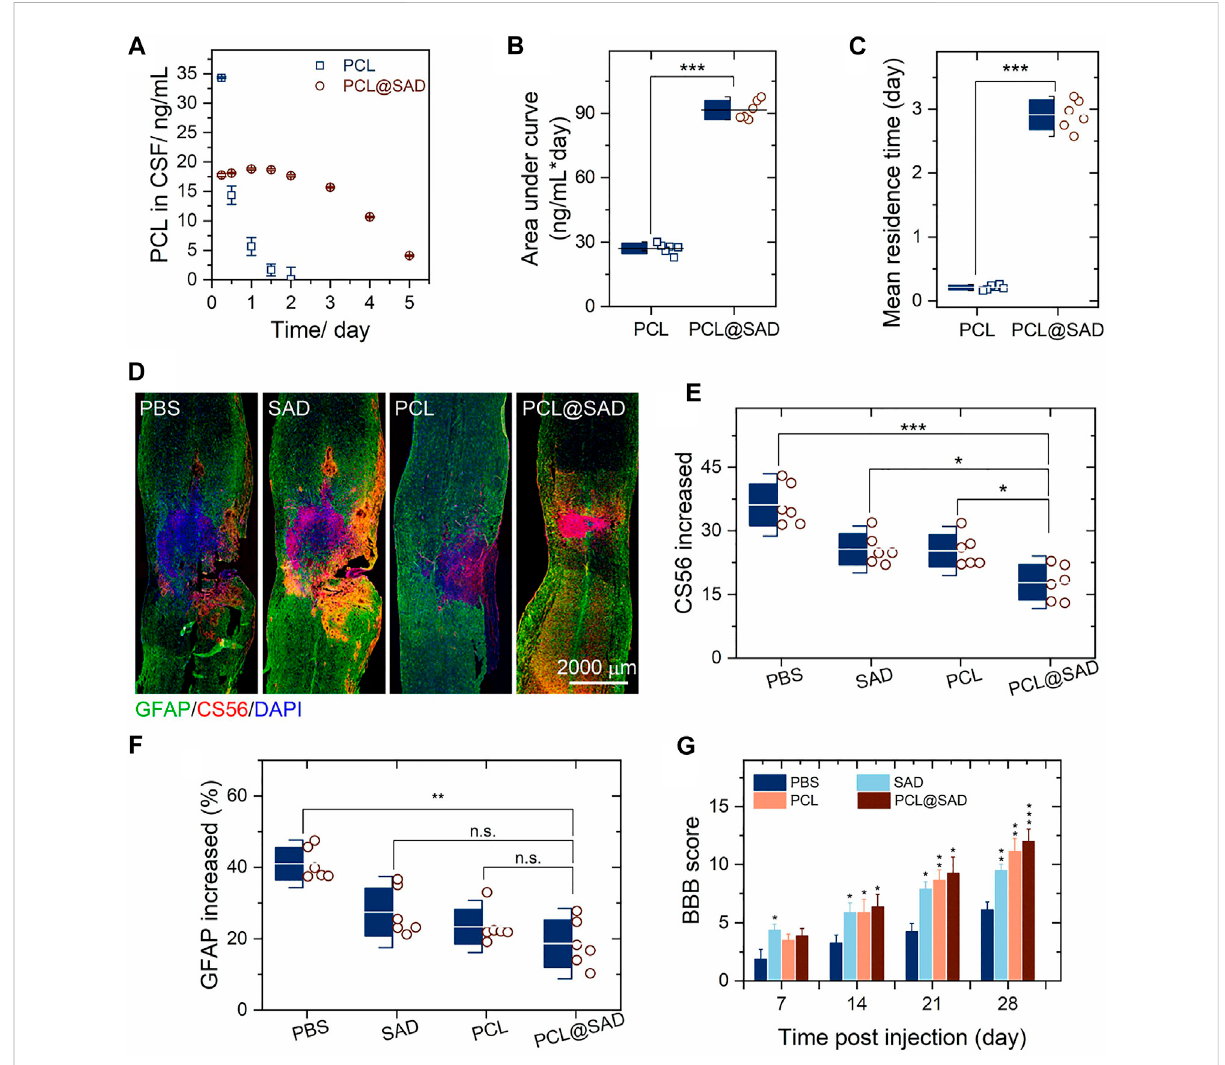
FIGURE 3 PCL@SADimprovesfunctionalrecoveryafterspinalcordinjury( n =6). (A – C) ConcentrationofPCLinthecerebrospinal fl uid(CSF)asafunction of time after intrathecal administration of PCL and PCL@SAD, and the corresponding area under curve (AUC; b) and mean residence time (MRT; c). (D) Representative immunohistochemical staining of CS56 (in red) and GFAP (in green) in spinal cord tissues at day 28 post-injury. (E,F) Semi- quanti fi cation of CS56 (E) and GFAP (F) intensity and density in the injured spinal cord. (G) The effect of PCL@SAD on the BBB grading score of spinal cord injured rats. * p < 0.05, ** p < 0.01, and *** p <